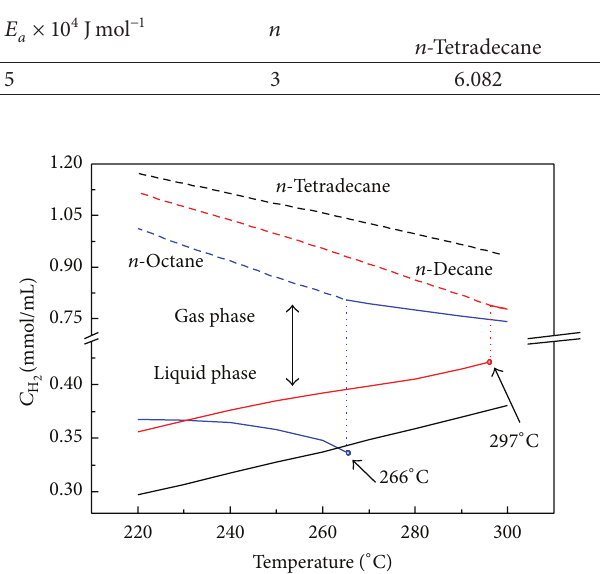
Figure 5: The hydrogen concentration in gas and liquid phases of different solvents calculated by SRK equation of state.